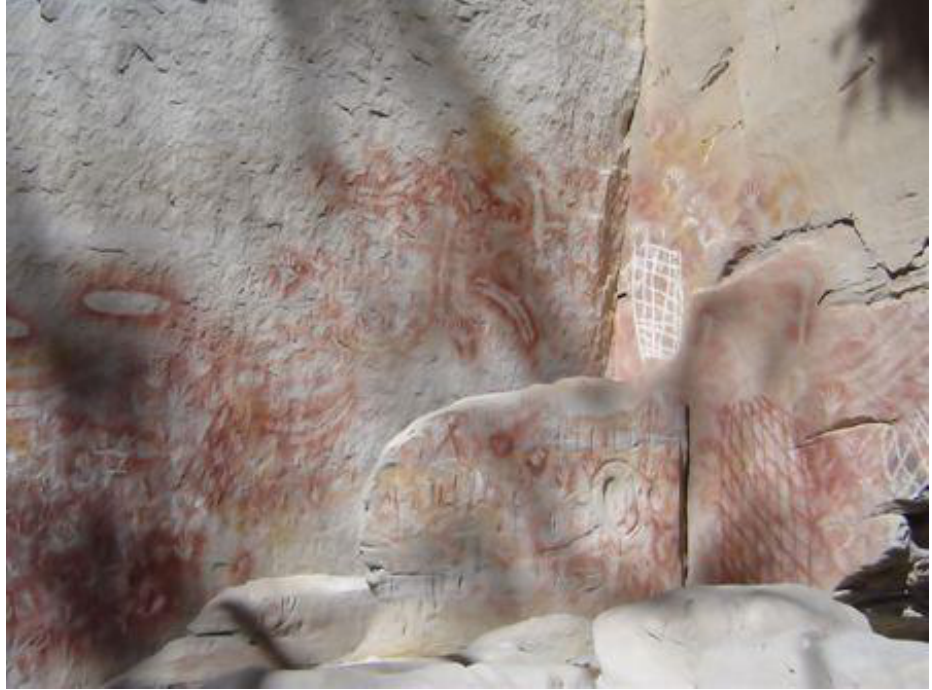
Figure 3. “Art Gallery”, Carnarvon Gorge, Queensland, Australia. Courtesy B.